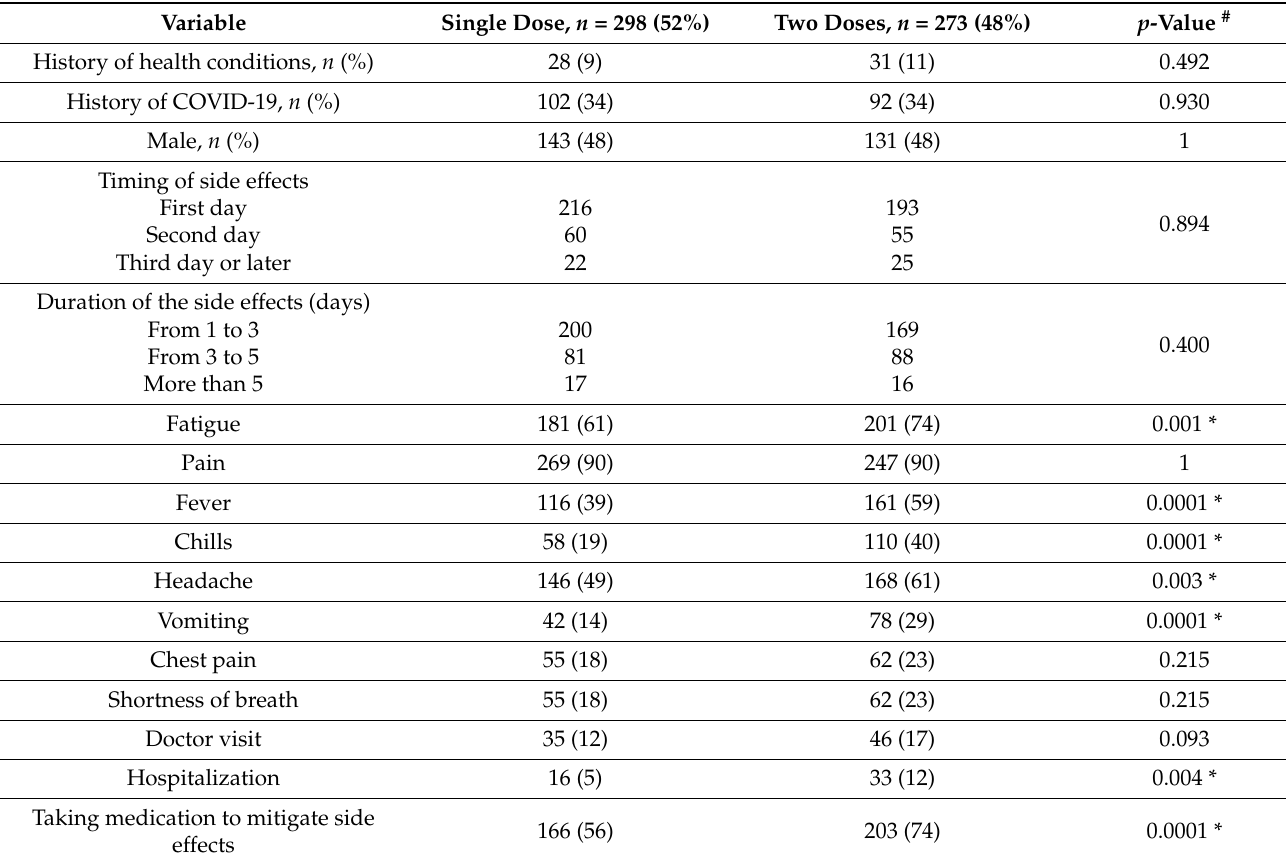
Table 5. Comparison of side effects after one or two doses of the Pfizer-BioNTech (BNT162b2) vaccine.